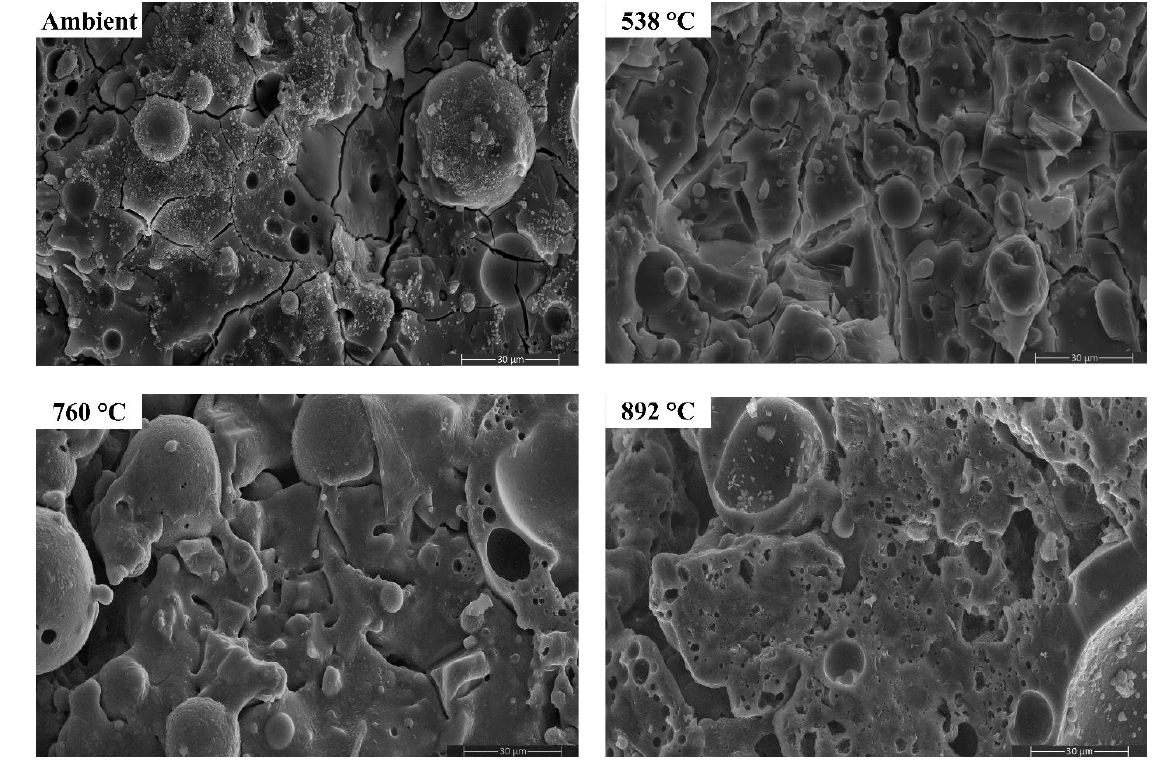
Figure 17. SEM micrographs of FS 40P-1.4 exposed to high temperatures.